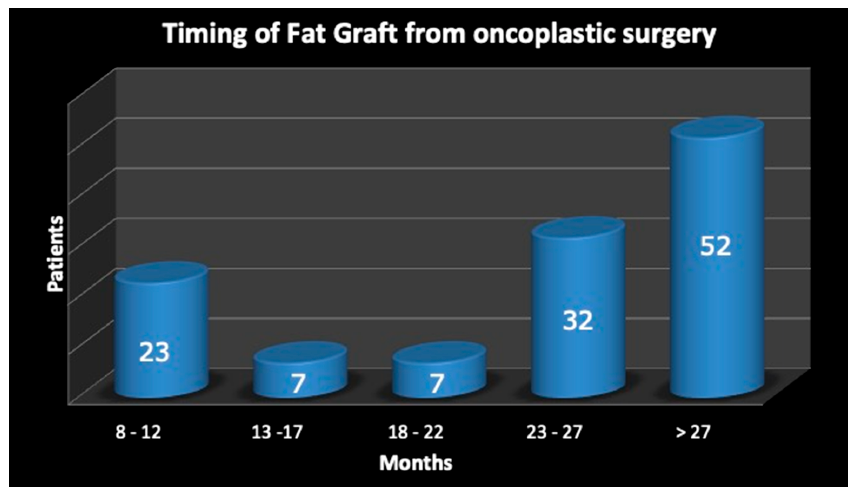
Figure 2. The timing of fat graft, performed after oncoplastic surgery.